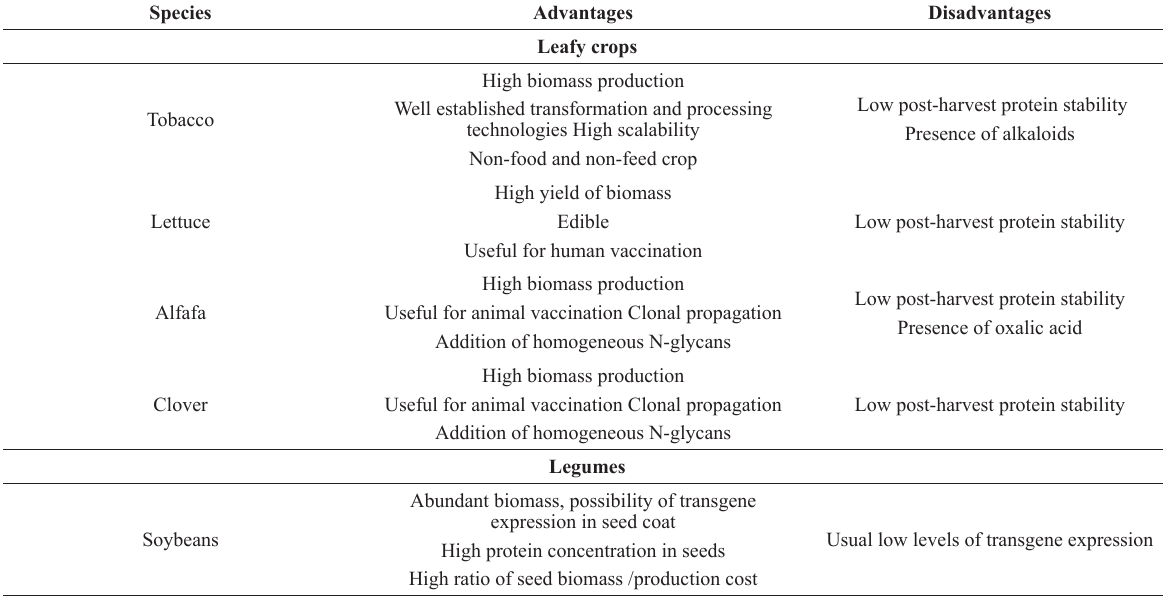
Plant species used as bioreactors of